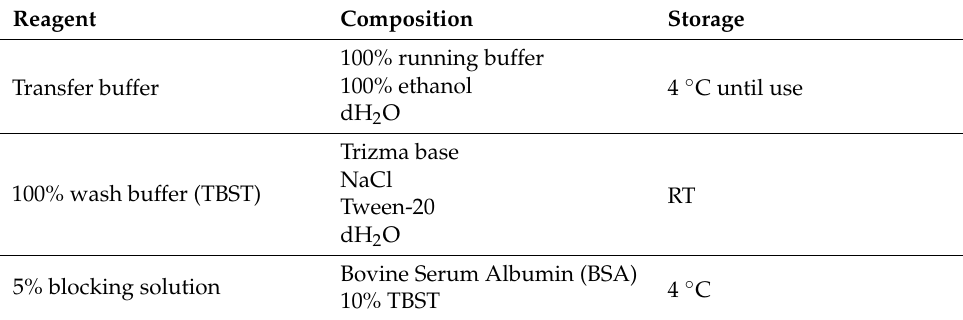
Table 5. Composition and storage of Western blot reagents.